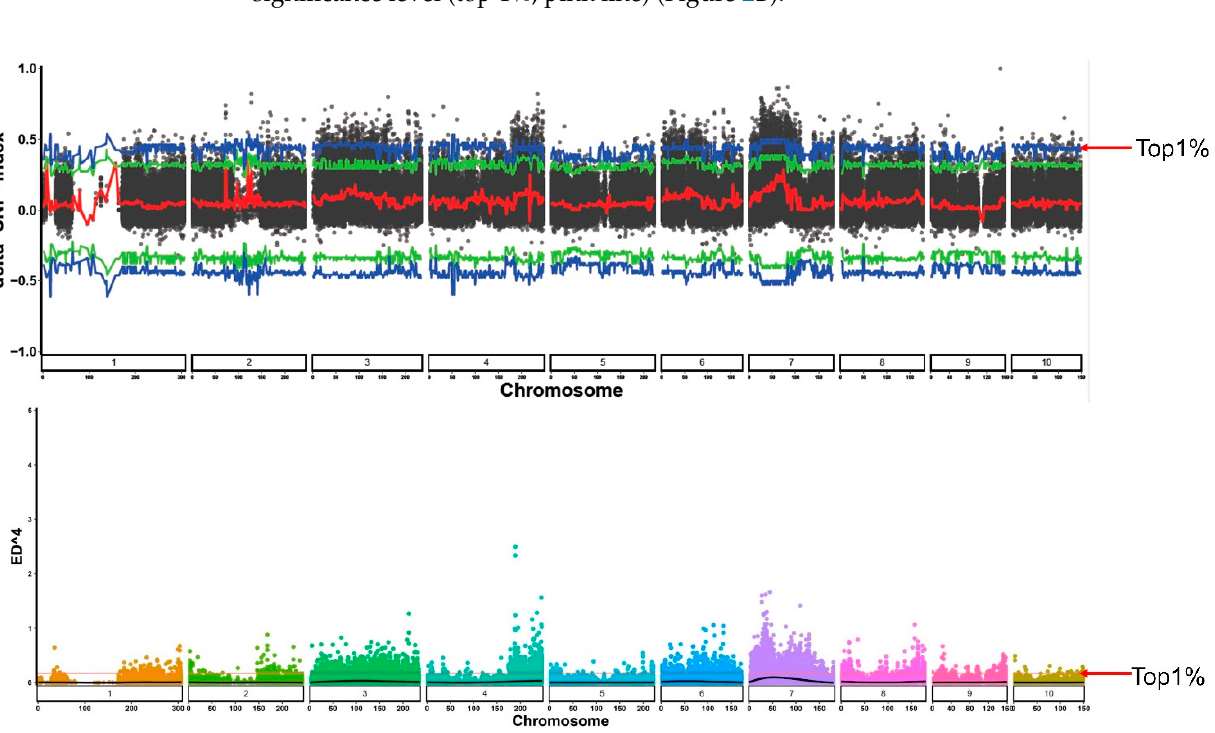
Figure 2. BSA: ( A ) SNP/InDel-index method and ( B ) ED method. Blue and red arrows indicate the top 1% threshold value in the two different methods, respectively.